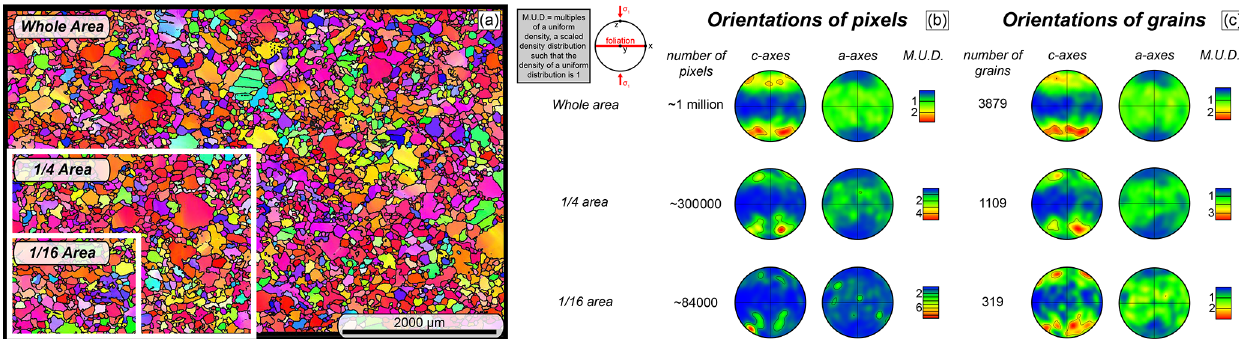
Figure A1. EBSD map and associated CPO plots for sample PIL36 deformed in uniaxial compression at − 9 . 8 ◦ C from Qi et al. (2017), highlighting the difference in representing data as all-pixel orientations vs. one-point-per-grain orientations as a function of sample size. (a) EBSD map, with boxes representing subsampled areas. (b) CPO plots ( c and a axes) of all pixel orientations from the entire sample area, 1 / 4 of the sample area and 1 / 16 of the sample area. (c) CPO plots ( c and a axes) of one-point-per-grain orientations from the entire sample area, 1 / 4 of the sample area and 1 / 16 of the sample